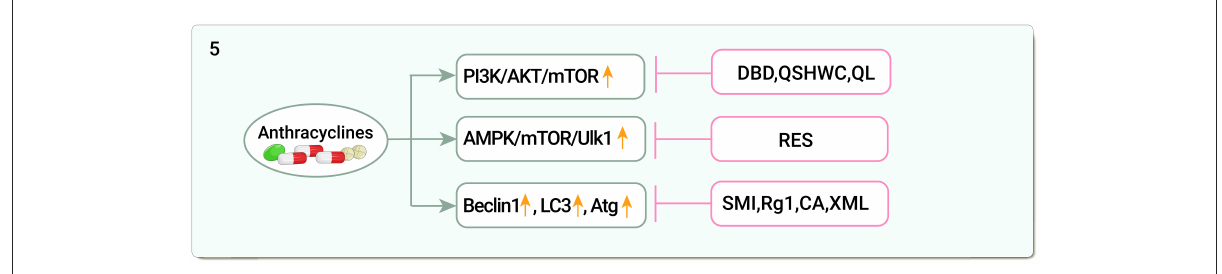
FIGURE5 Traditional Chinese medicine alleviates cardiotoxicity associated with chemoradiotherapy by regulating autophagy (PI3K/AKT/mTOR, phosphatidylinositol 3-kinase/serine-threonine protein kinasem/Mechanistic Target Of Rapamycin; AMPK/mTOR/Ulk1, Adenosine monophosphate-activated protein kinase/Mechanistic Target Of Rapamycin /Unc-51-like autophagy activated kinase; LC3, Light chain-3; Atg, Autophagy-related genes; DBD, Danggui Buxue decoction; QSHWC, Qishen Huanwu Capsule; QL, Qiliqiangxin; RES, Resveratrol; SMI, Shenmai